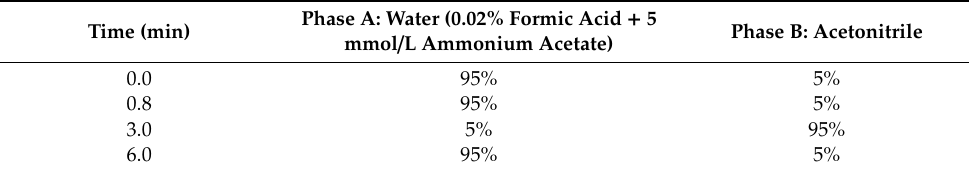
Table 1. Gradient elution